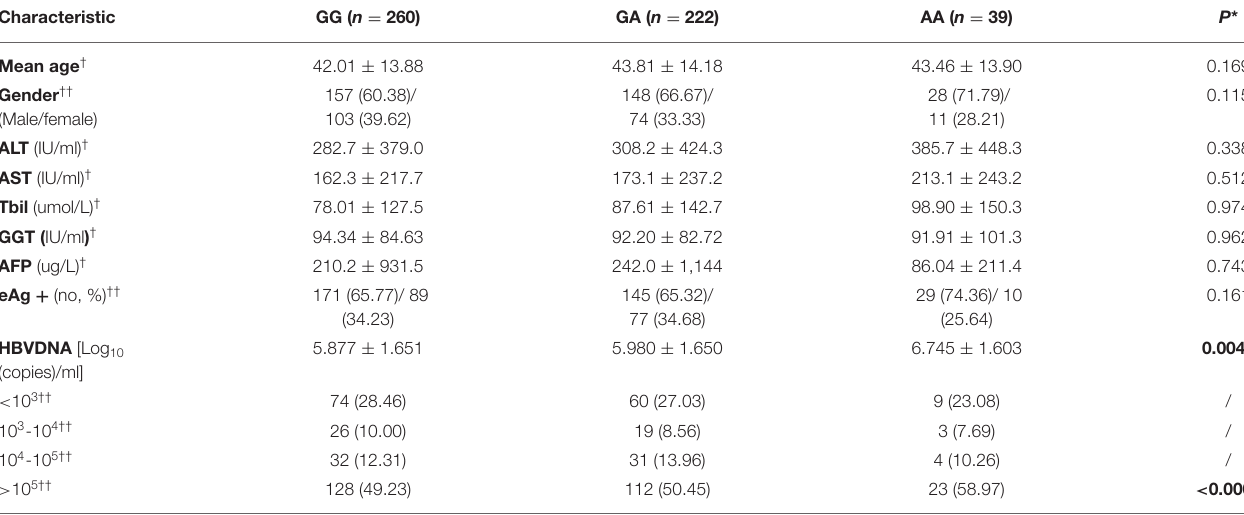
TABLE 5 | Comparison of clinical features levels between subjects with different genotypes at rs671 in the CHB ( n = 521) group.